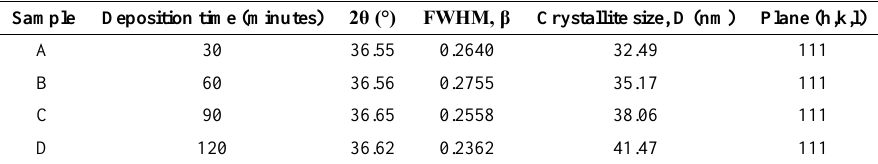
Table 1. Structural parameters of Cu 2 O/TiO 2 nanorods/FTO with different Cu 2 O deposition time calculated from XRD